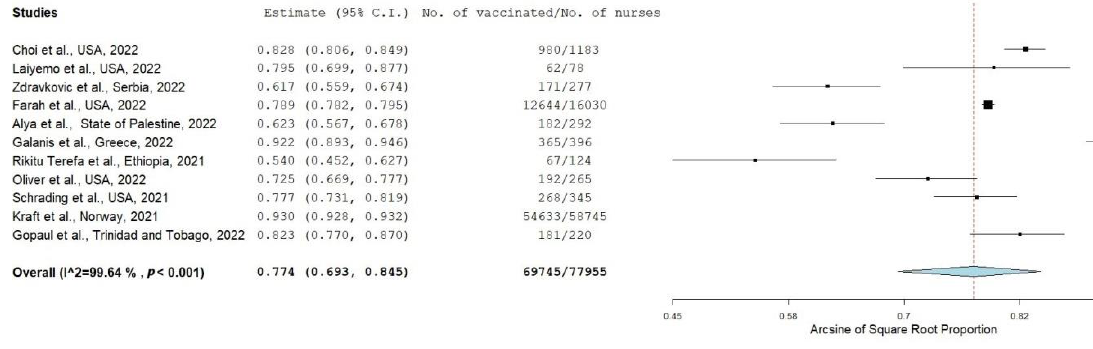
Figure 4. Forest plot of nurses vaccinated against COVID-19. [32,34,37,43–45,48,49,52,53,55] .